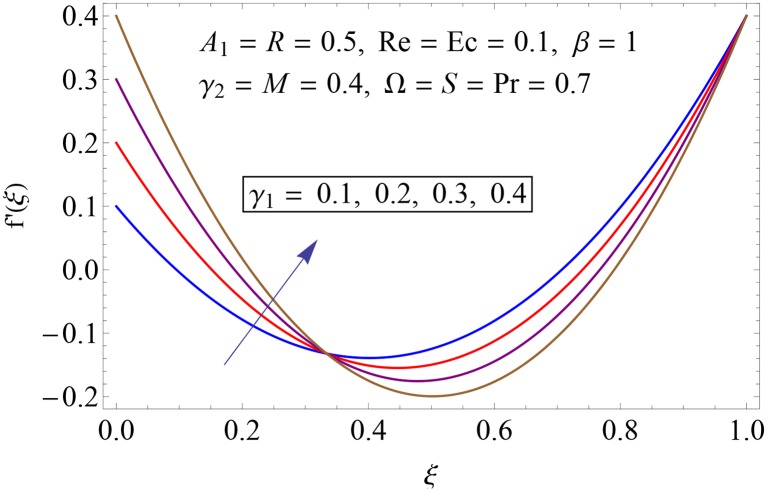
Impact of γ1 on f′(ξ).